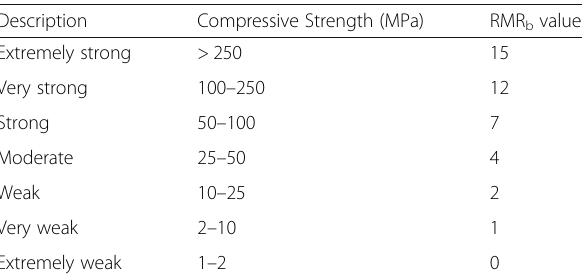
Table 2 Rock Quality Designation (RQD) classification